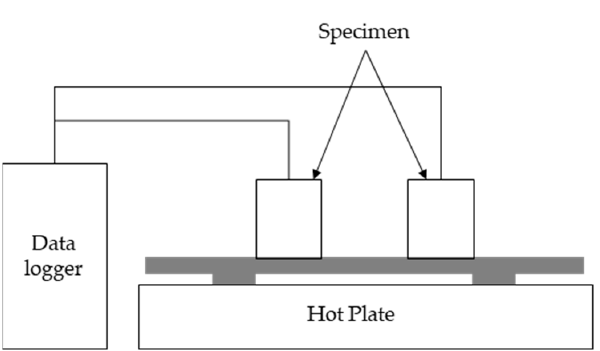
Figure 3. Thermal diffusion and heat storage test device.